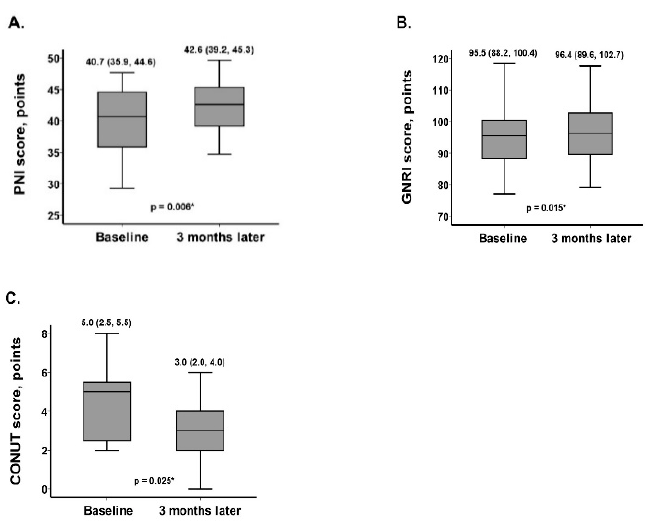
Figure 1. Trends of three nutrition scores during 3 months of SZC therapy, including PNI score ( A ), GNRI score ( B ), and CONUT score ( C ). * p < 0.05 by the Wilcoxon signed-rank test.